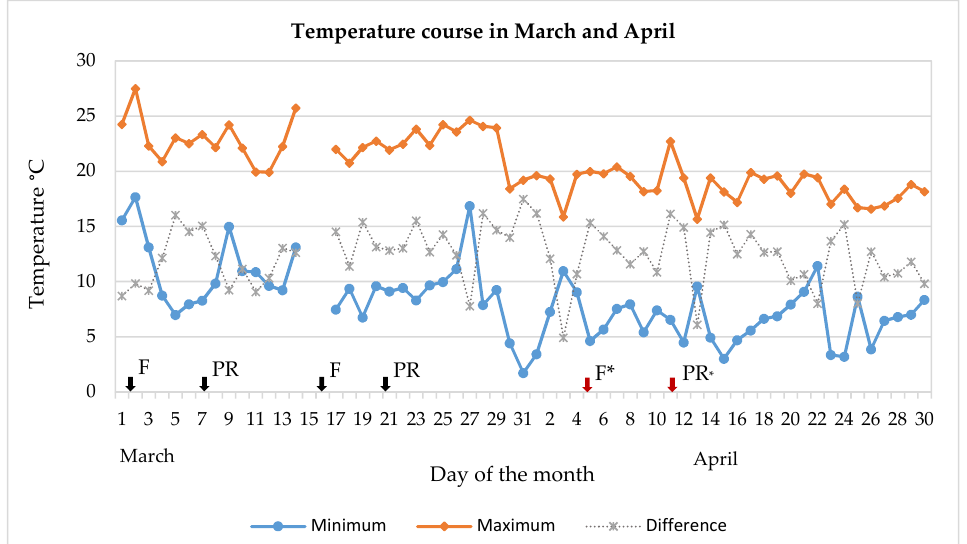
Figure 2. Temperature curve in March and April at HortResearch, Motueka, New Zealand, during the experiment- black arrows indicate the dates of laying the reflective material for Fuji (F) and Pacific Rose (PR) and the red arrows for the begin of the harvest (asterisks).